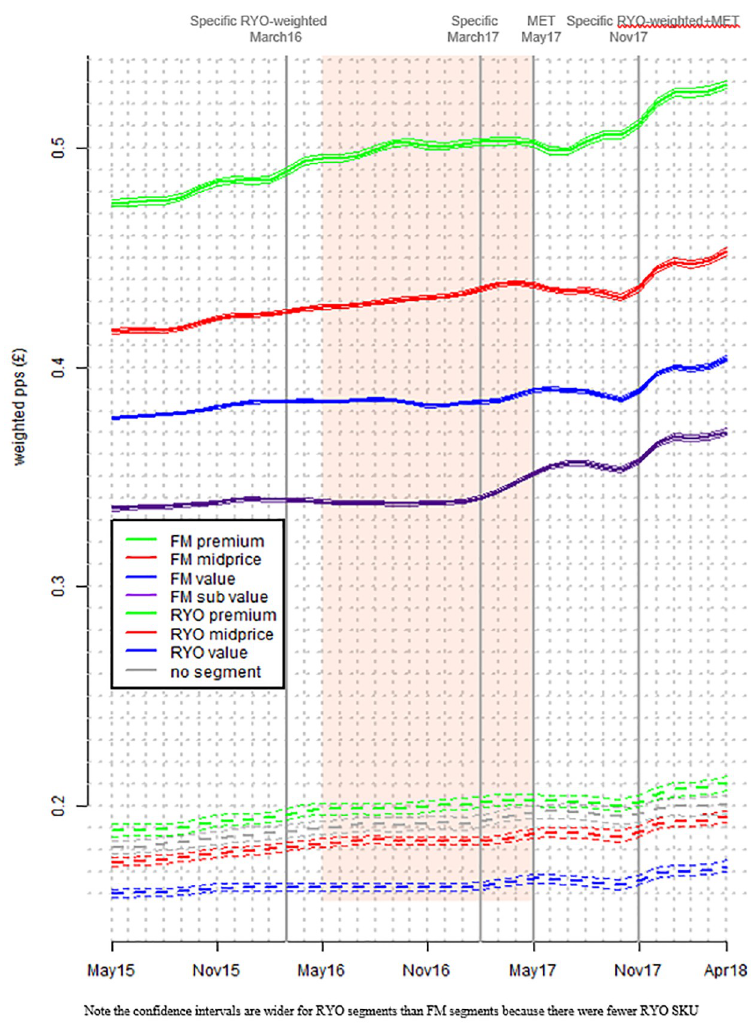
Fig 2. Mean and 95% confidence intervals (CI) of weighted real price per stick by (a) FM market segment and (b) RYO market segment and no segment (vertical lines denote tax changes and the shaded area is the standardised packaging implementation